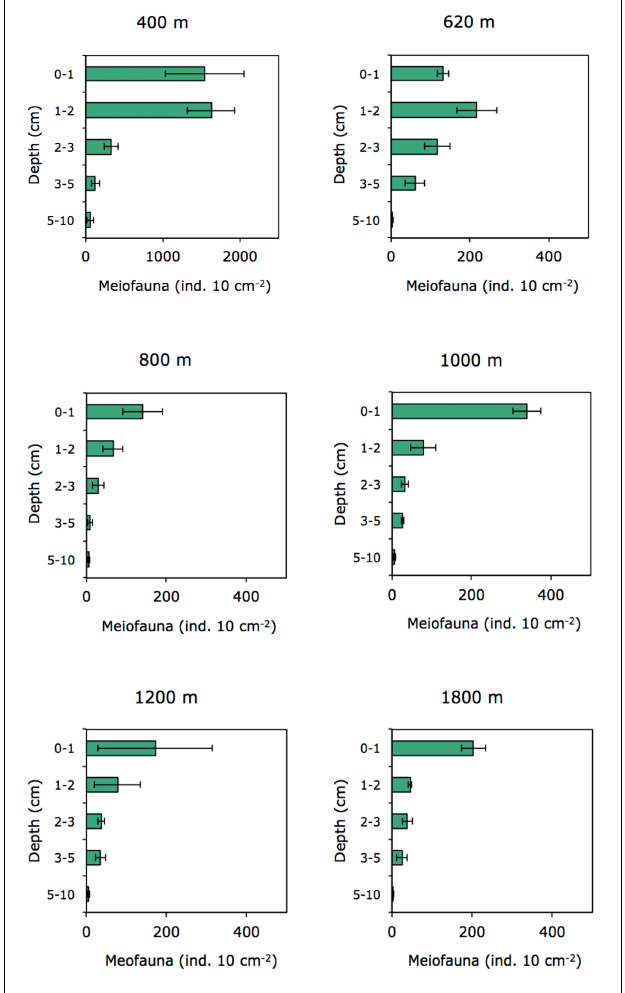
FIGURE 8 | Vertical distribution of meiofauna within the sediment column on the Costa Rica margin.